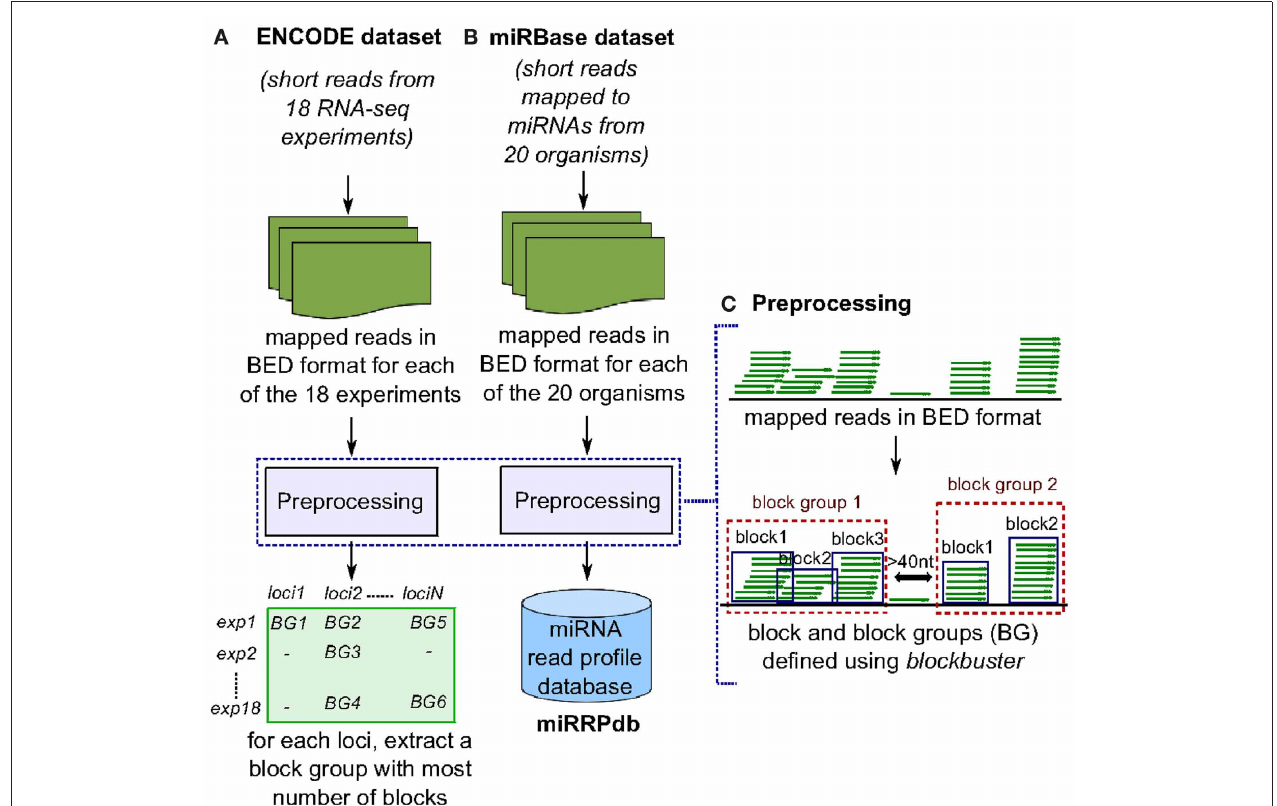
FIGURE 2 | Preprocessing of ENCODE and miRBase datasets. (A) In ENCODE dataset, reads mapped to human genome from each of the 18 RNA-seq experiments were subjected to preprocessing to obtain closely spaced set of reads termed here as “block group”. Block groups thus obtained were compiled so as to identify a set of distinct genomic loci that have a block group in at least one experiment. Next, for each locus, we retrieved one block group corresponding to the experiment in which the block